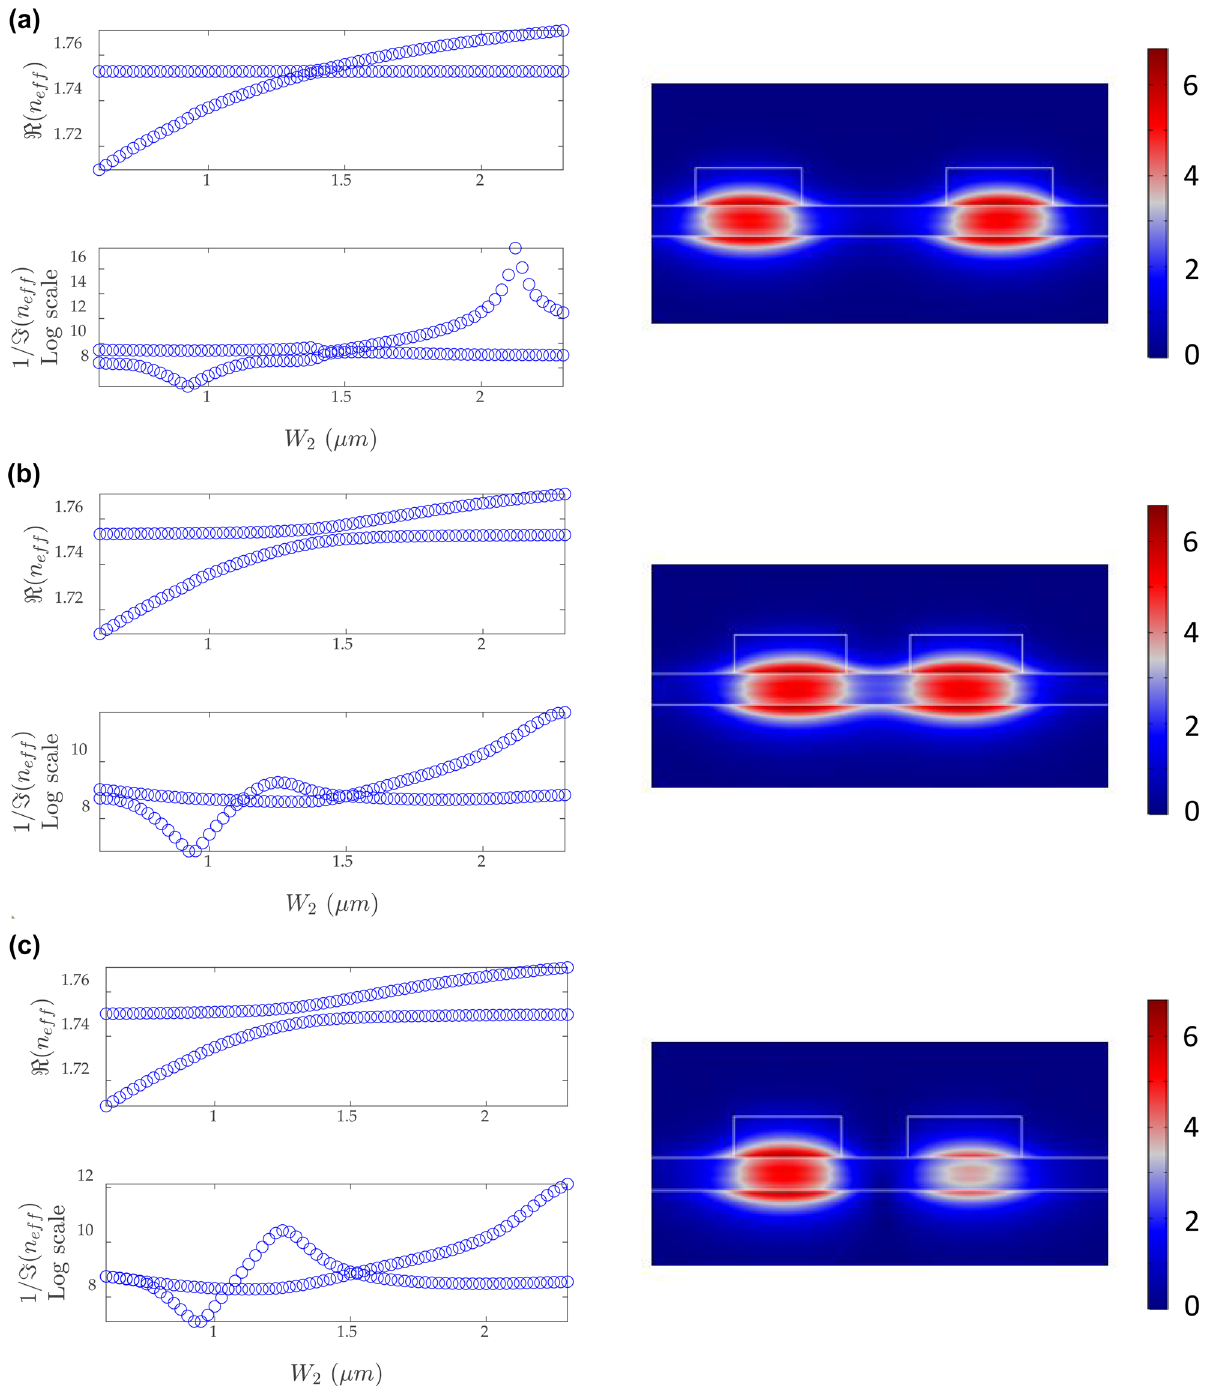
of the dual modes versus W eff = 1.4 μ m, dis = 1.9 μ m, (b) W 1